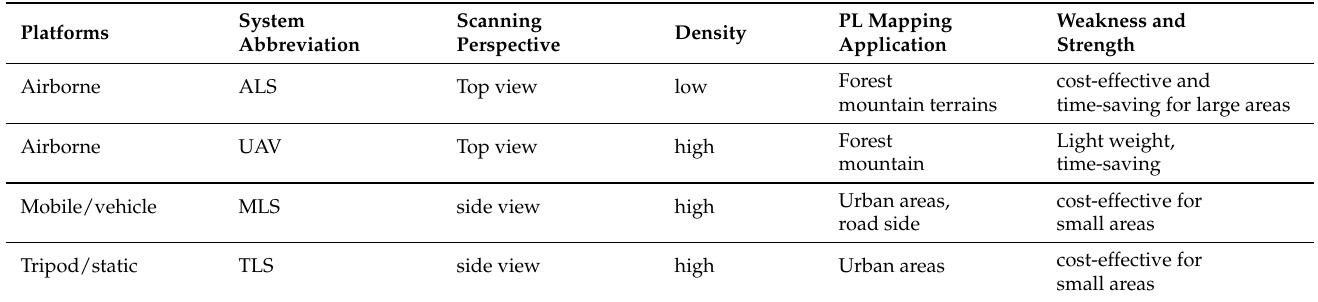
Table 1. Comparison of LiDAR systems mounted on different